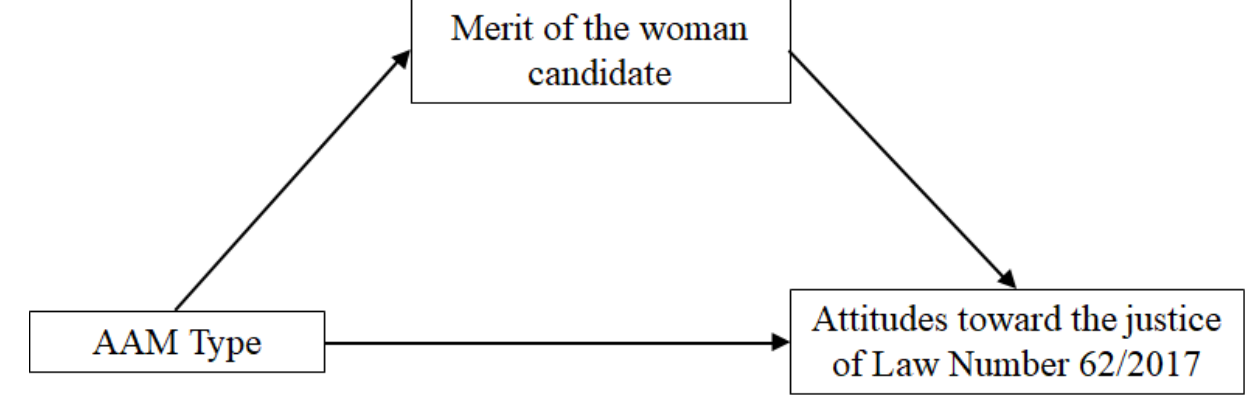
Figure 2. Additional mediation model. AAM – Affirmative Action Measure